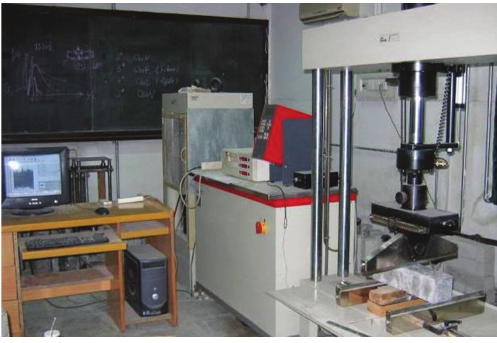
Figure 5: σ -w for basic concrete.